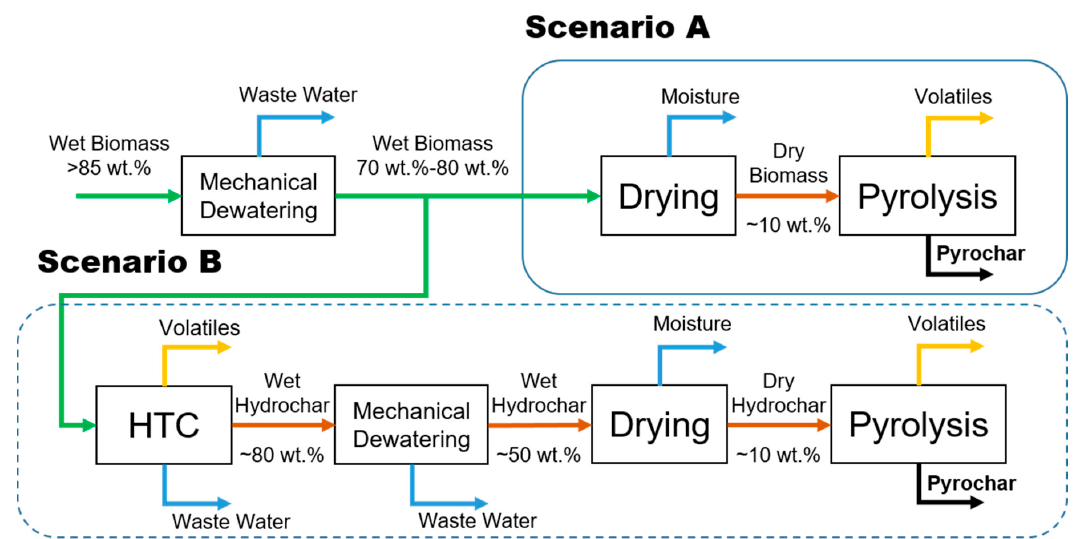
Figure 1. Simplified process flow diagram; Scenario ( A ) conventional pyrolysis, Scenario ( B ) the integration of hydrothermal carbonization (HTC) with pyrolysis.